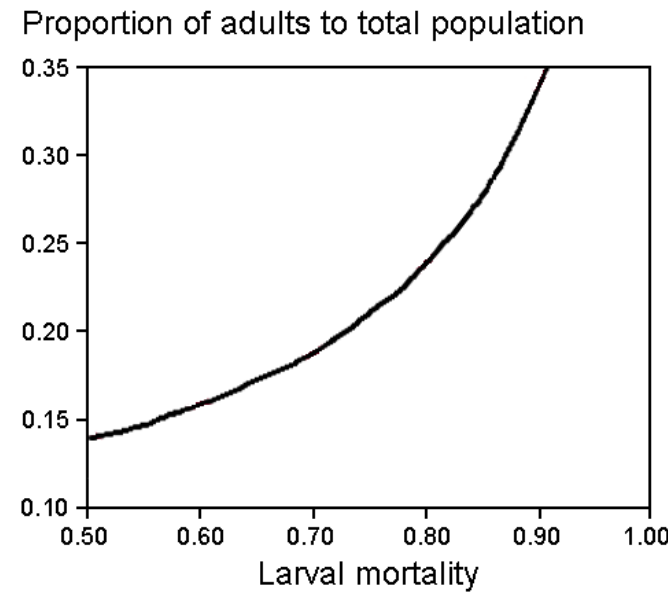
Figure A3. The contribution of adults to the total population of Chioglossa lusitanica (vertical axis, N/N b ) as a function of larval mortality (horizontal axis, q l